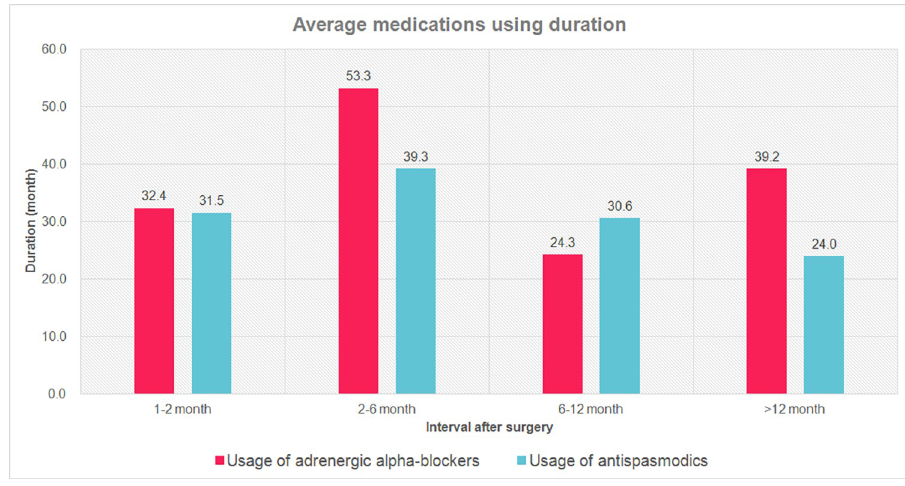
Fig 2. Average adrenergic alpha-blockers and antispasmodics using duration with respect to medicine initiating times.